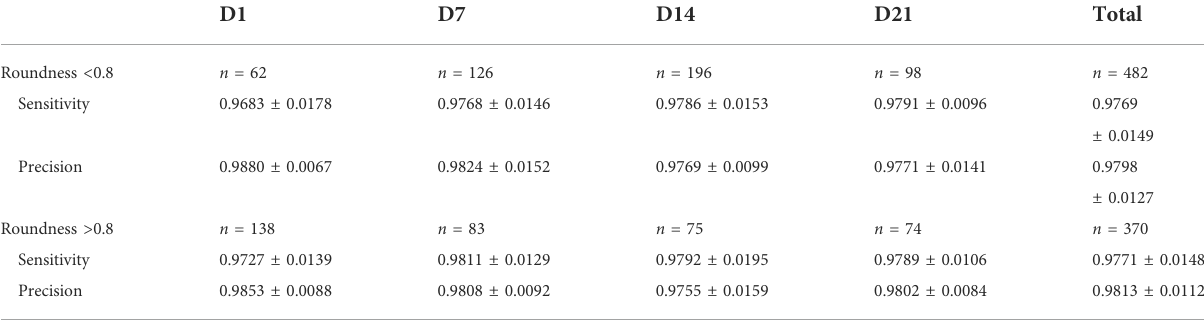
TABLE 2 Sensitivity (TPR) and precision (PPV) of the automatic segmentation approach. Sensitivity and precision of the proposed methodology with respect to manual segmentation. For each validation set, the results are presented as mean ± SD, with N the number of samples per data set.